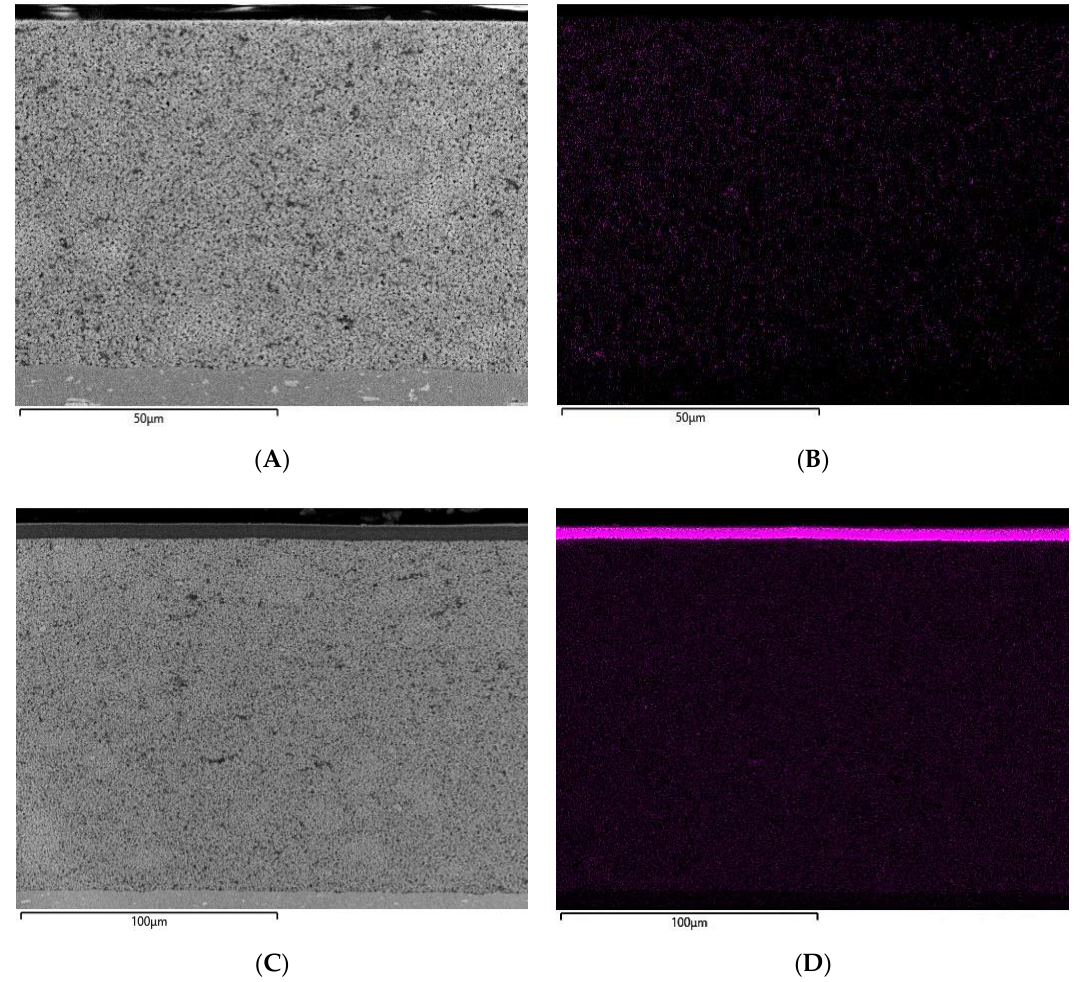
Figure 6. FESEM cross-section (SE-detector) prepared by focused ion beam of: ( A ) sample of pristine LTO without PCPE; ( B ) EDS mapping of sulfur in pristine LTO (control sample); ( C ) infiltrated and laminated LTO sample with PCPE; ( D ) EDS mapping of sulfur in infiltrated and laminated LTO with PCPE.